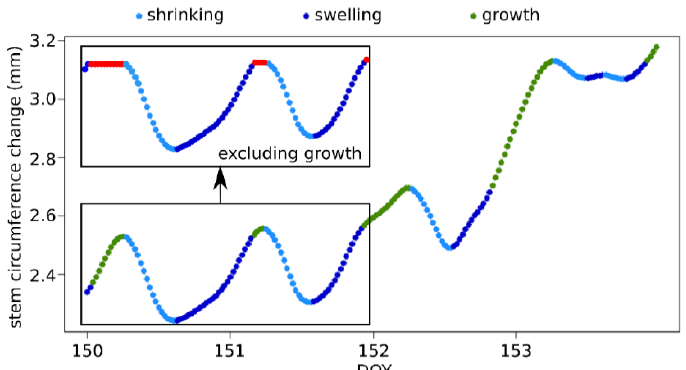
Figure 2. Schematic figure explaining the classification of the stem circumference change into shrinking, swelling, and growth, and the exclusion of the growth component, created with the R-program dendRoAnalyst [36]. Each dot represents a 30-min measurement recorded in 2017.